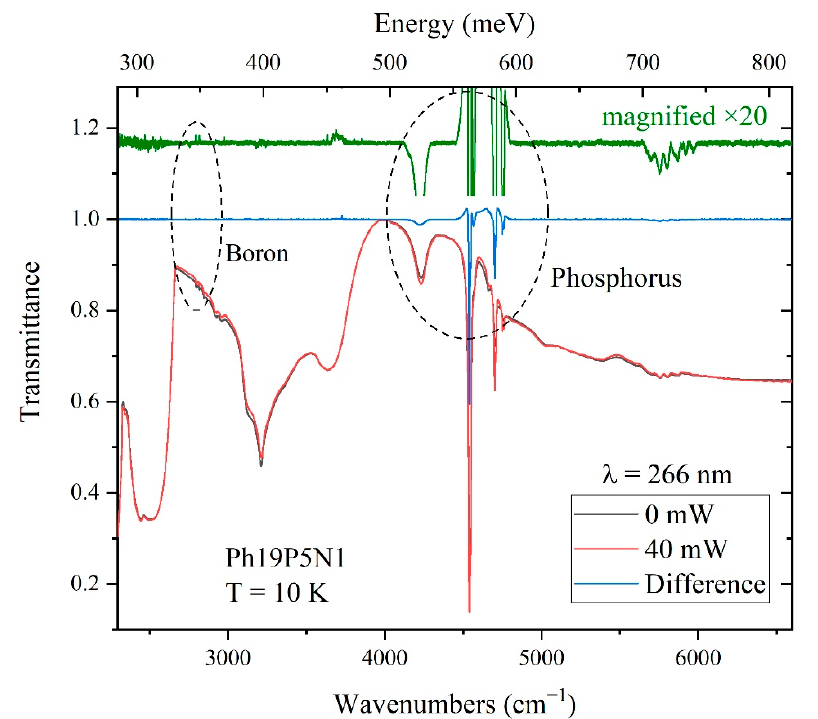
Figure 4. Transmission spectra of diamond sample Ph19P5N1 at 10 K without (black) and with (red) irradiation by laser; black – red difference spectrum (blue) and magnified difference spectrum (green). Irradiation by laser with wavelength λ = 266 nm and power 40 mW.